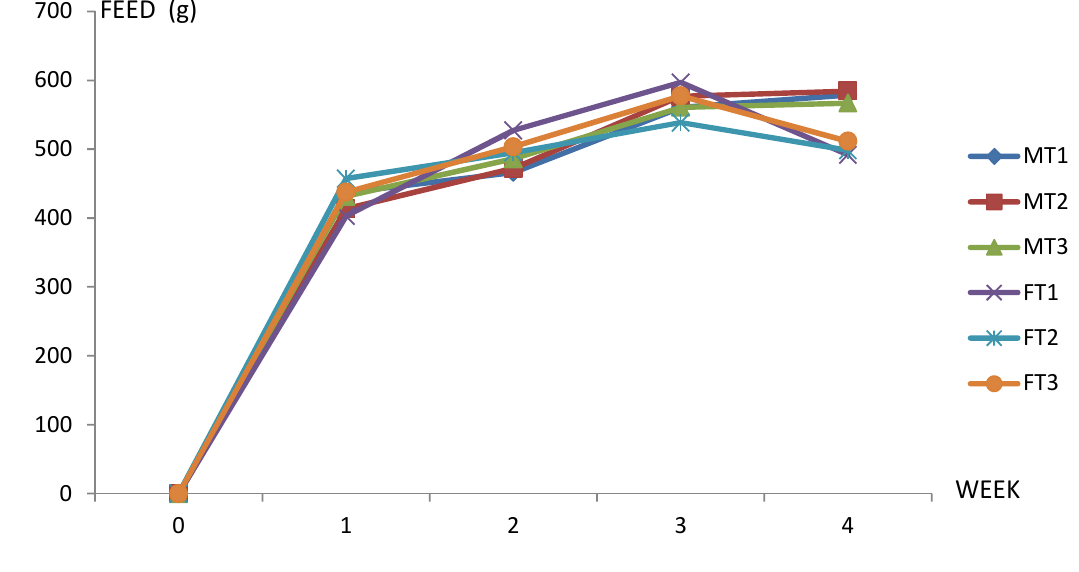
Fig. 1. Feed intake patterns of the experimental